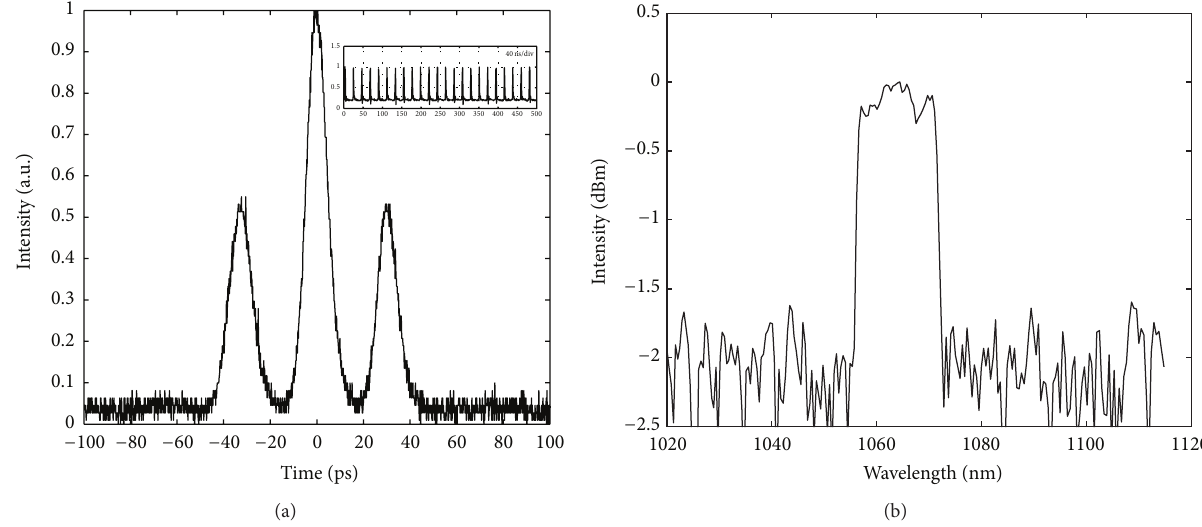
Figure 5: Characteristics of a bound state of dissipative solitons. (a) Autocorrelation trace. Inset, pulse train. (b) Optical